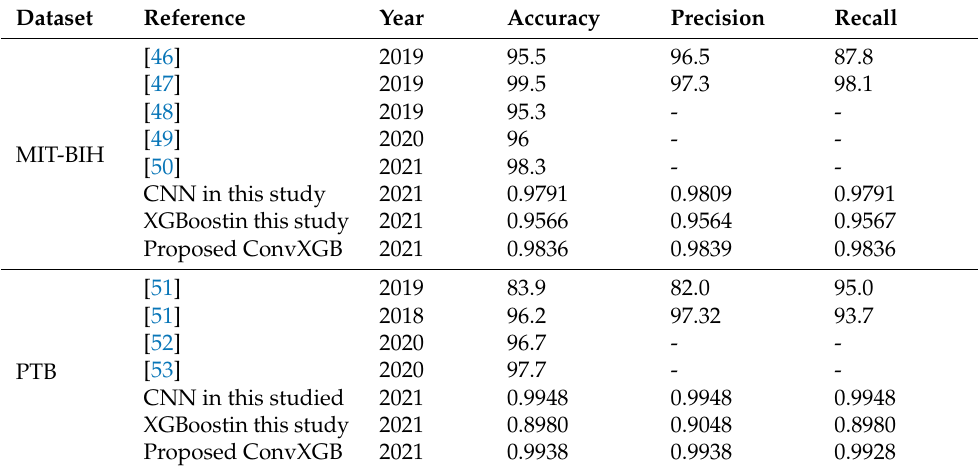
Table 6. Comparison of the performance of the proposed model with the performance of state-of-the- art models.